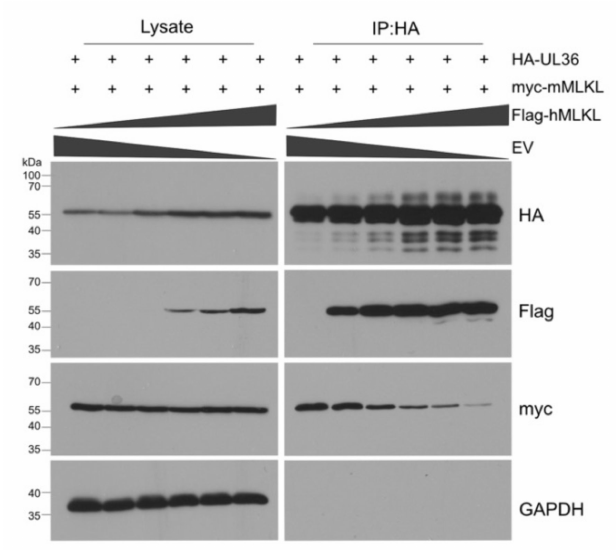
Figure 4. HCMV UL36 has stronger affinity to human than to murine MLKL. HEK-293A cells were co-transfected with 2.6 µ g of plasmid expressing HA-tagged UL36, 2.6 µ g of plasmids expressing myc-tagged mMLKL and increasing concentration (from 0 µ g to 2.6 µ g, black triangles) of plasmid expressing Flag-tagged hMLKL. HA-tagged UL36 was immunoprecipitated, and co-precipitating myc-tagged mMLKL and Flag-tagged hMLKL were detected by Western blot. Empty vector (EV) plasmid was used to normalize the total amount of transfected DNA. + indicates transfection with HA-UL36 and myc-mMLKL plasmids, respectively.